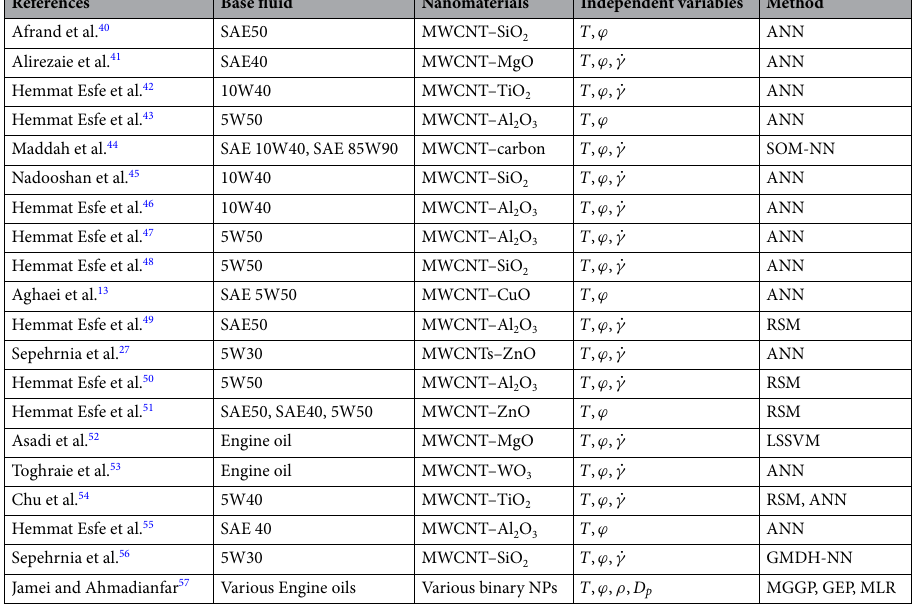
Table 1. Overview of the papers on machine learning approaches in dynamic viscosity modeling of engine oil-based hybrid